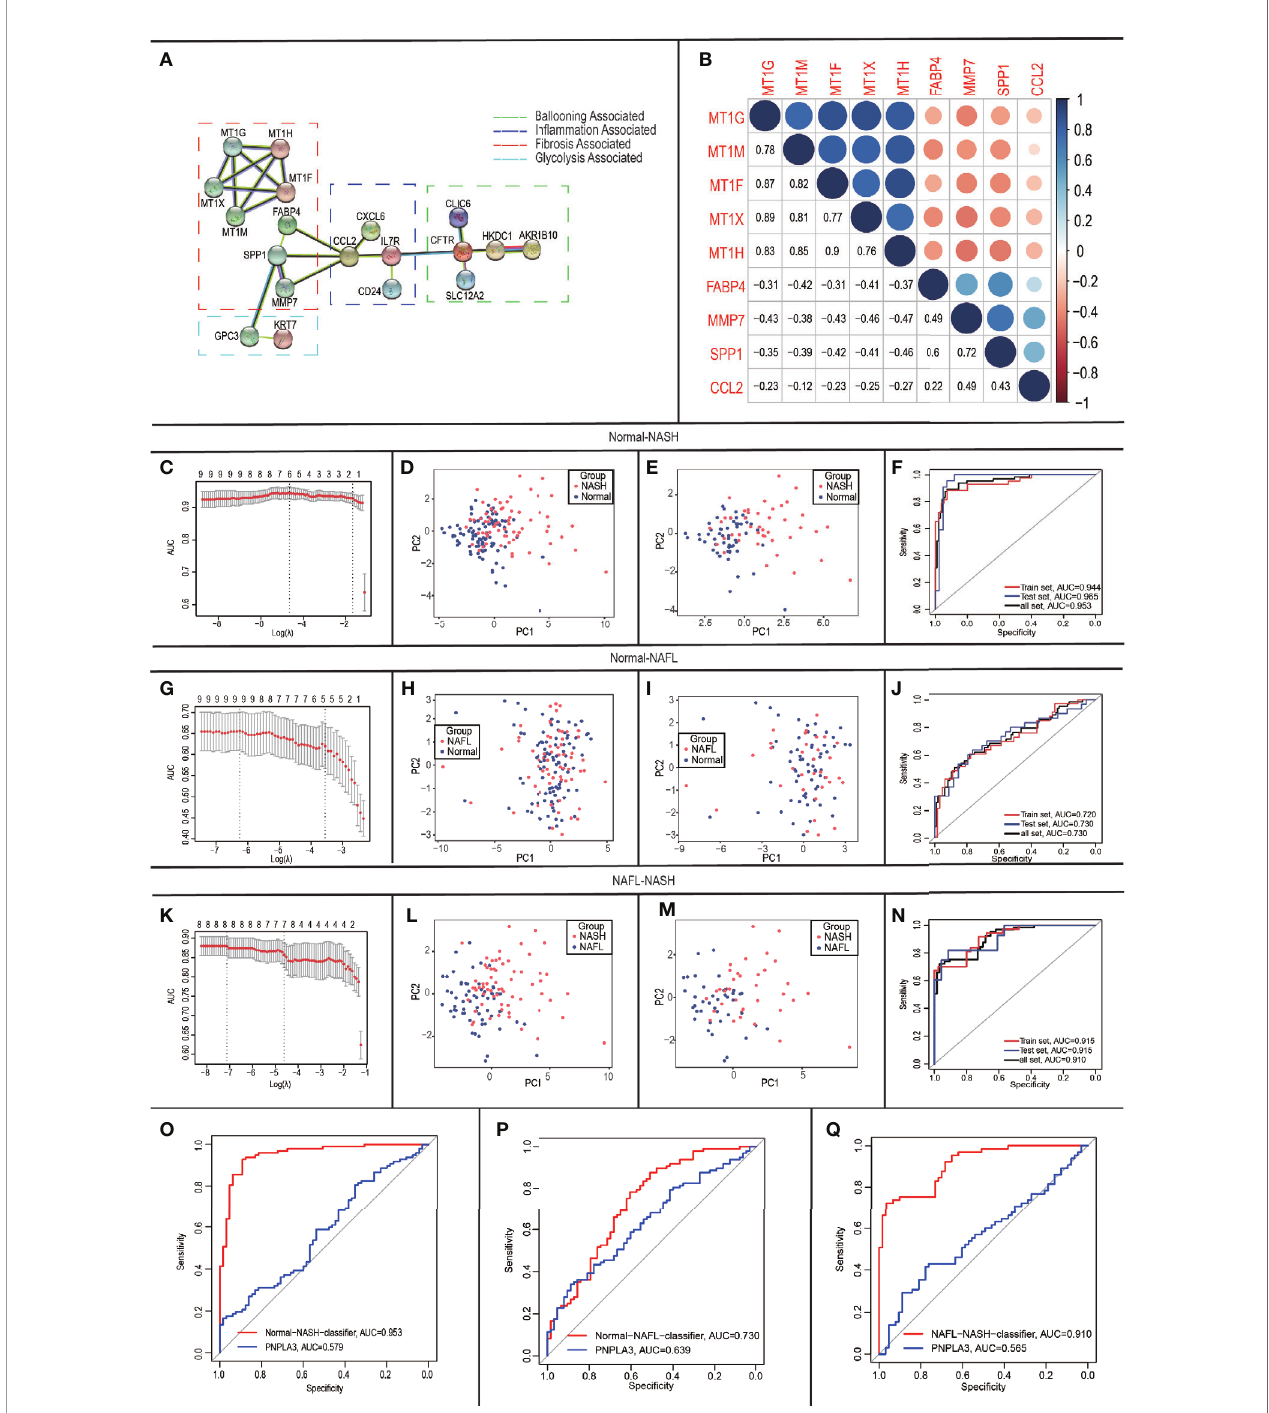
FIGURE 5 | Construction and validation of LASSO logistic regression classi fi ers. (A) Protein-Protein Interaction interactions among 19 DEGs; (B) Correlation analysis of nine core genes; (C-F) In Normal-NASH group, parameter selection in the LASSO model (C) ; principal component analysis before (D) /after (E) parameter selection; Receiver operating characteristic analyses in the training, the testing and the total group (F) ; (G-J) In Normal-NAFL group, parameter selection in the LASSO model (G) ; principal component analysis before (H) /after (I) parameter selection; Receiver operating characteristic analyses in the training, the testing and the total group (J) ; (K-N) In NAFL-NASH group, parameter selection in the LASSO model (K) ; principal component analysis before (L) /after (M) parameter selection; Receiver operating characteristic analyses in the training, the testing and the total group (N) ; (O-Q) Receiver operating characteristic analyses between classi fi er and PNPLA3 in Normal-NASH group (O) /Normal-NAFL group (P) /NAFL-NASH group (Q)